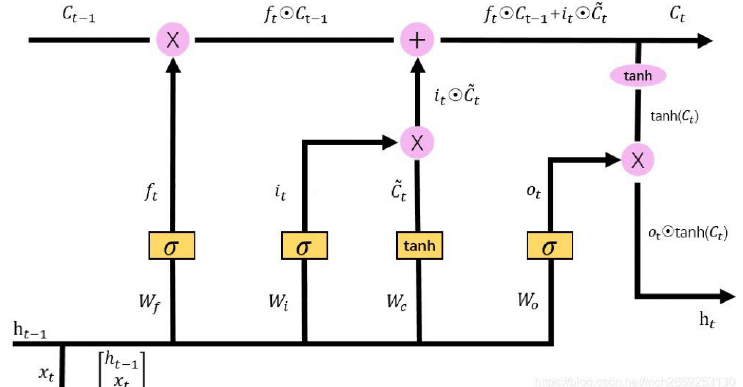
Figure 2. LSTM model